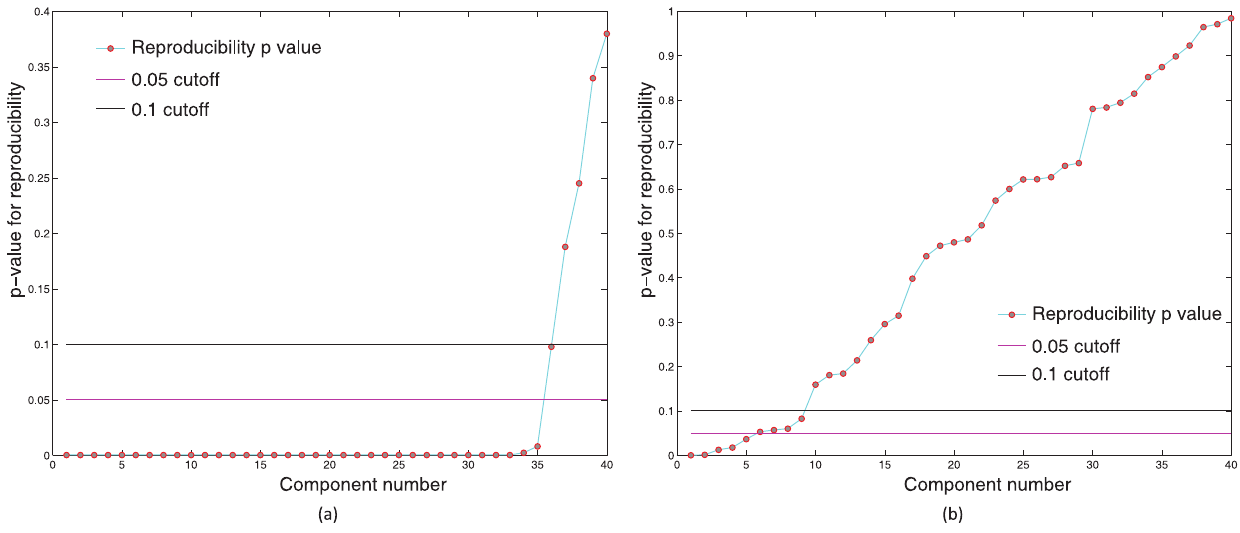
Figure 7. p -value cutoffs for within and across single subject analysis using RAICAR-N. This figure illustrates the intuitive fact that within subject ICA runs are much more reproducible compared to across subject ICA runs.